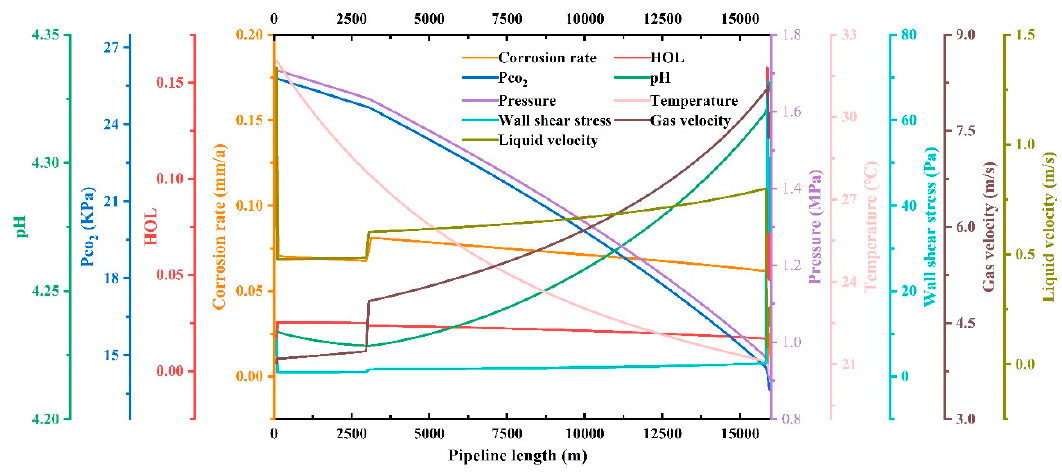
Figure 2. The curve of corrosion rate and corrosion factors with pipeline mileage. Table 3. The relative error between predicted and actual value.